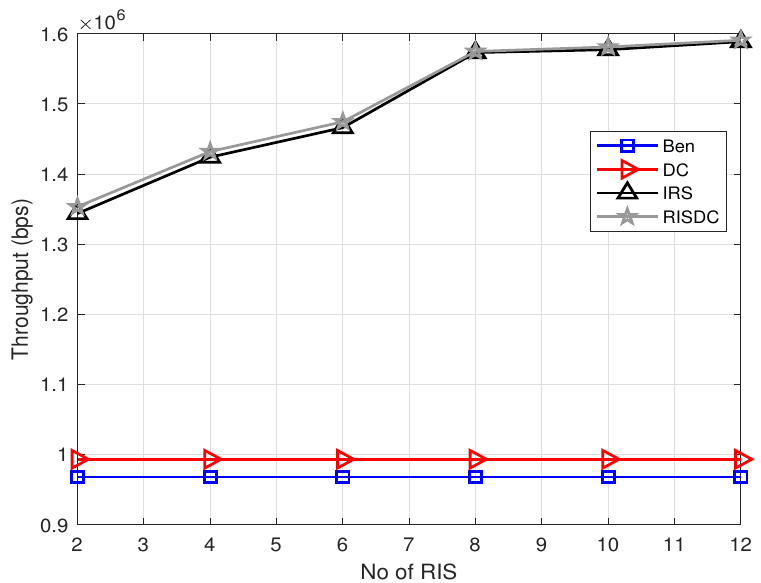
Figure 3. Variation of throughput with respect to number of RISs when ρ bs = 2, ρ user = 60, and µ b = 10.